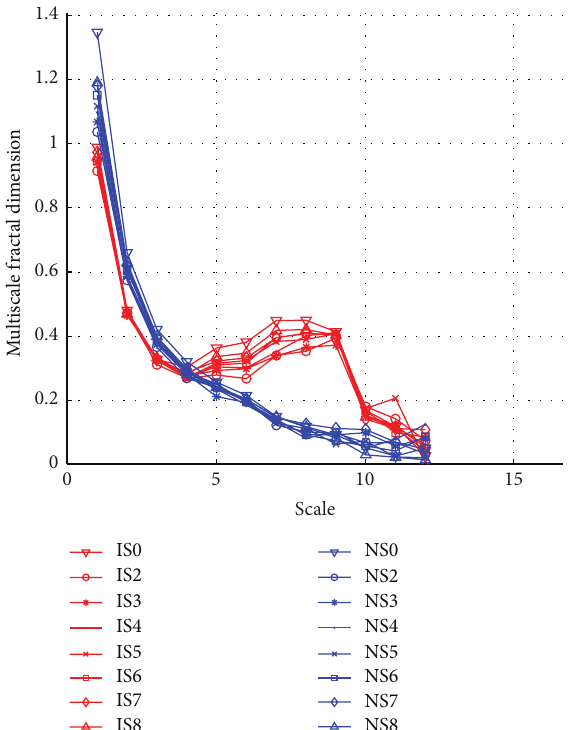
Figure 6: Multiscale general fractal dimensions with different SNR white